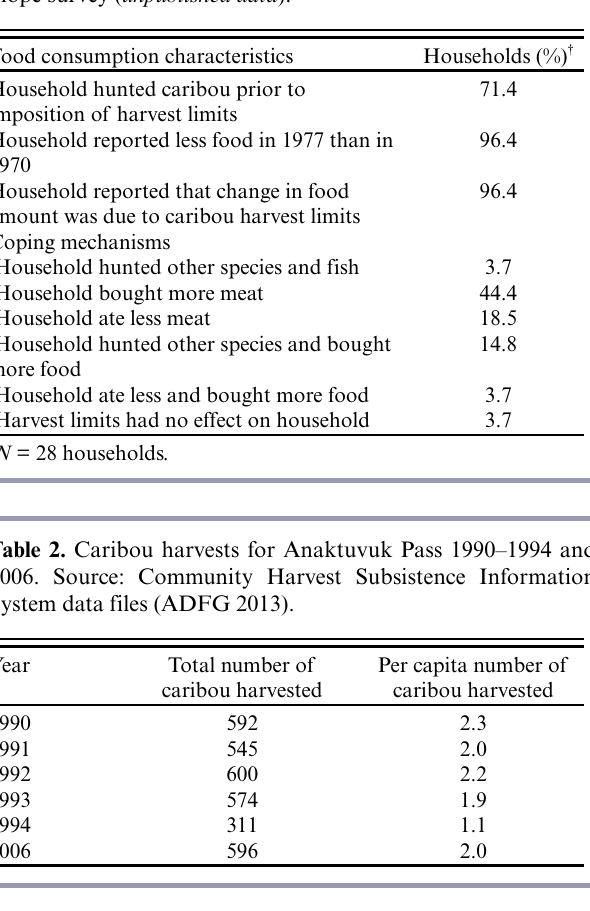
Table 1. Food consumption characteristics for Anaktuvuk Pass 1990–1994 and 2006. Source: Community Harvest Subsistence Information System data files (ADFG 2013) and 1978 North Slope survey ( unpublished data ).